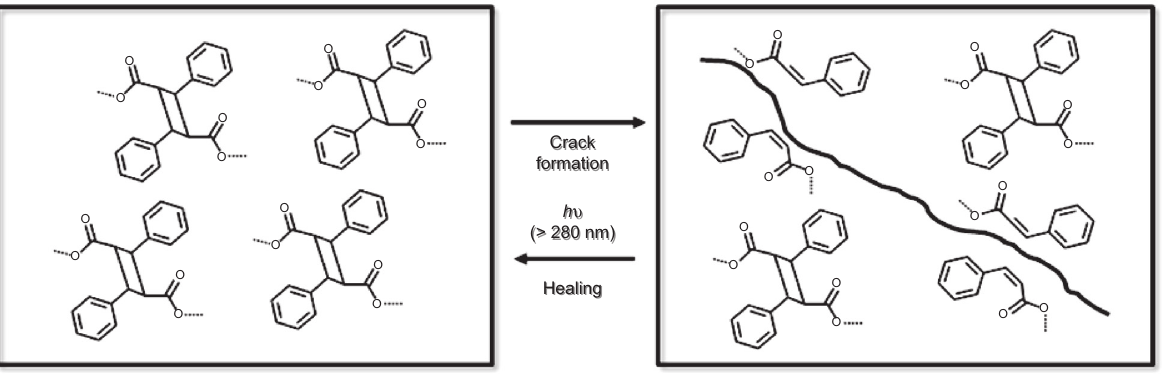
Scheme 2 Schematic representation of the self-healing mechanism via UV radiation (redrawn from